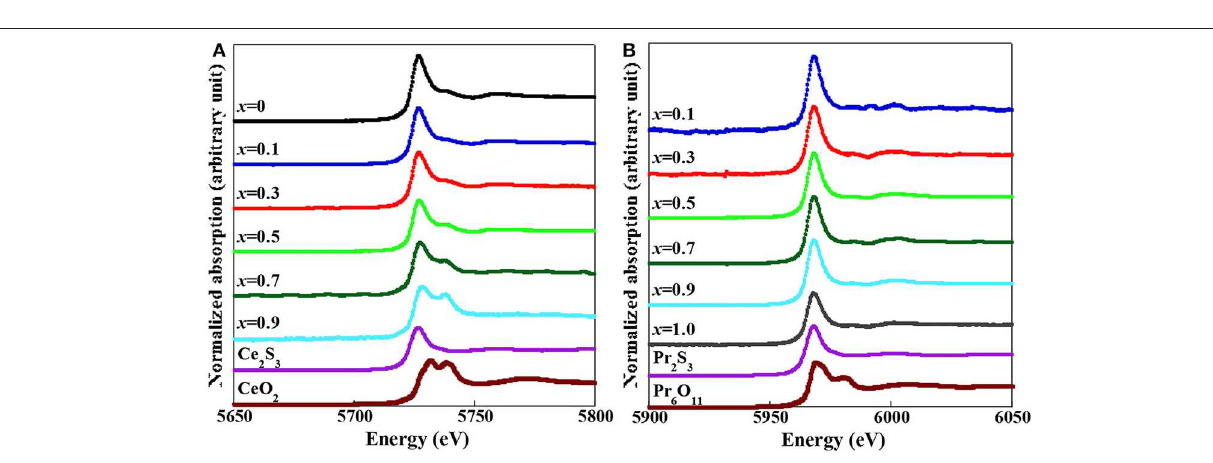
FIGURE 5 | (A) Ce L 3 -edge, XAFS obtained at room temperature for (Ce,Pr)OBiS 2 with 0.1 ≤ x ≤ 0.9 single crystals, CeOBiS 2 ( x = 0) single crystals, Ce 2 S 3 , and CeO 2 . (B) Pr L 3 -edge, XAFS obtained at room temperature for (Ce,Pr)OBiS 2 with 0.1 ≤ x ≤ 0.9 single crystals, PrOBiS 2 ( x = 1) ( Nagao et al., 2019) single crystals, Pr 2 S 3 , and Pr 6 O 11